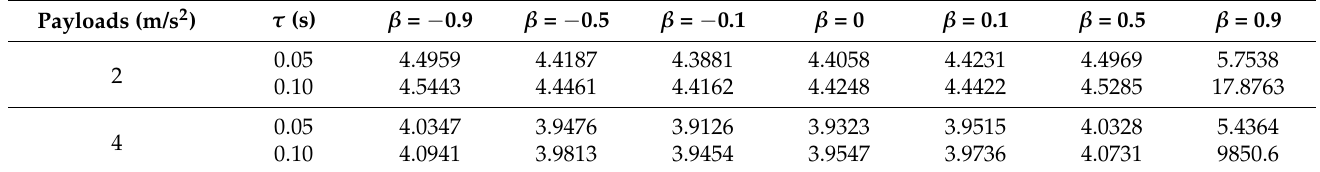
Table 14. Root mean squared value of the control signal u 1 in the first 30 s under different payloads, different input time delays and different fractional orders in the proposed controller.